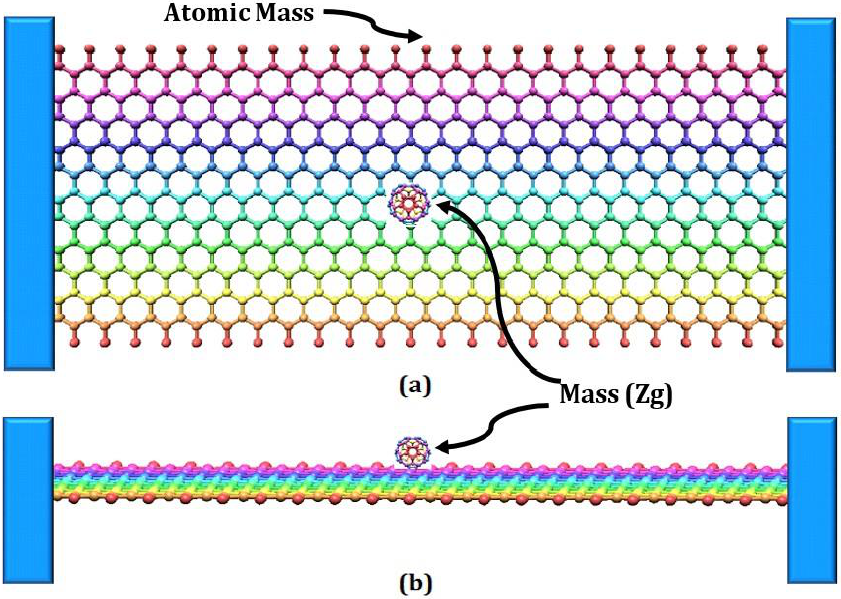
Figure 2. FEM model of bridged SLG with mass attached at centre. ( a ) SLG Top View with mass attached ( b ) SLG Front View Mass attached